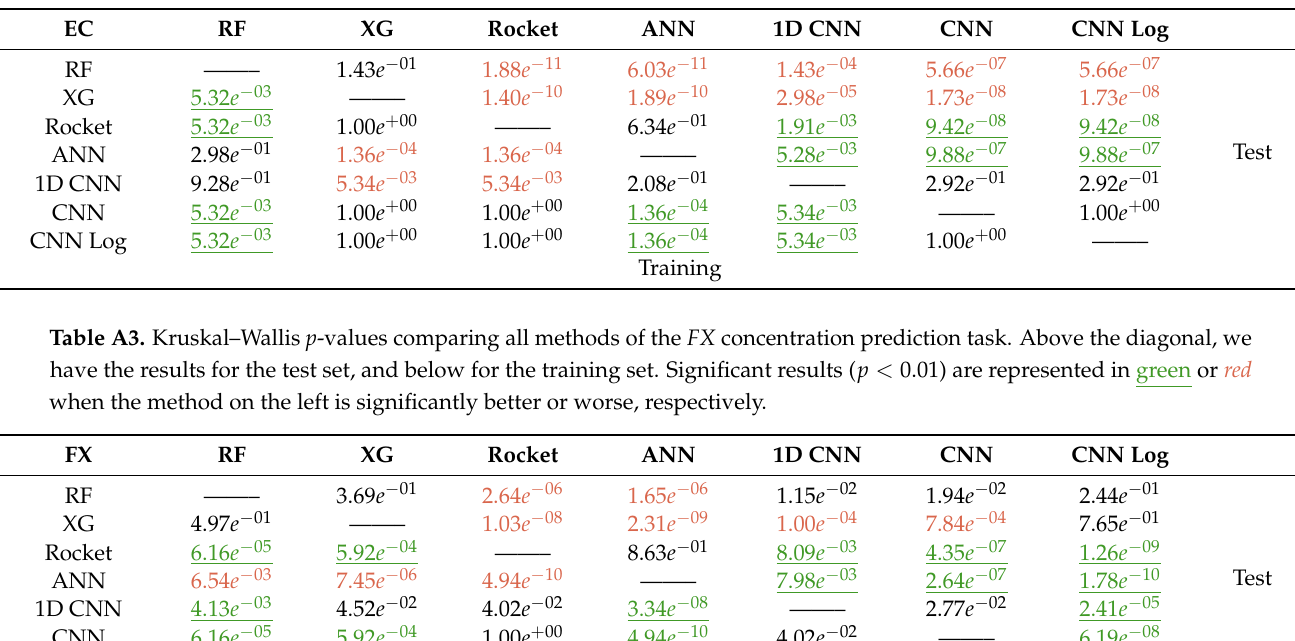
Table A2. Kruskal–Wallis p -values comparing all methods of the DCF concentration prediction task. Above the diagonal, we have the results for the test set, and below for the training set. Significant results ( p < 0.01) are represented in green or red when the method on the left is significantly better or worse, respectively.